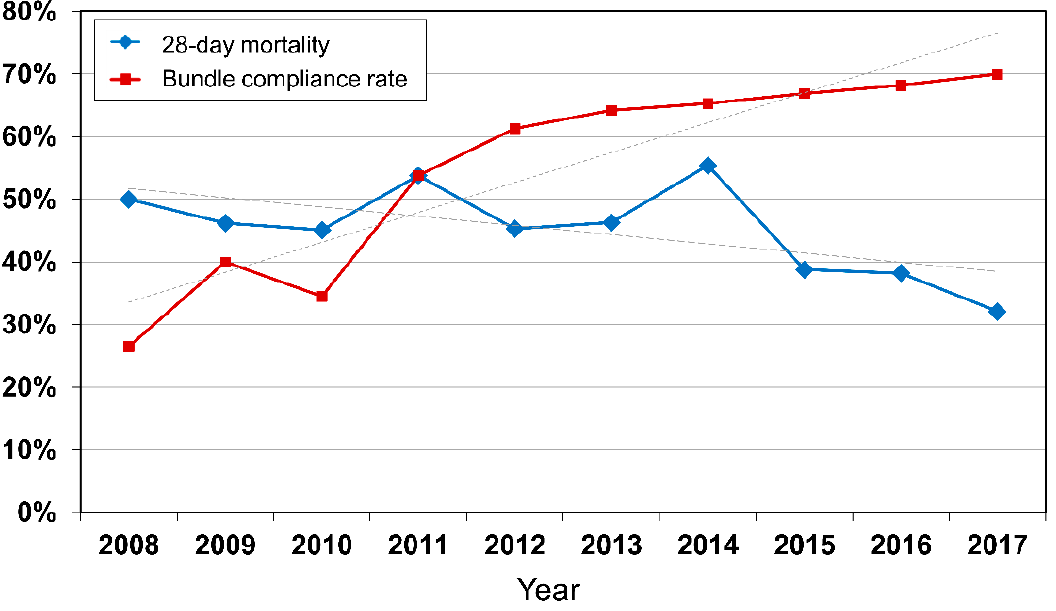
Figure 2. Compliance rate for achieving overall sepsis bundle and 28-day mortality rate of septic shock.